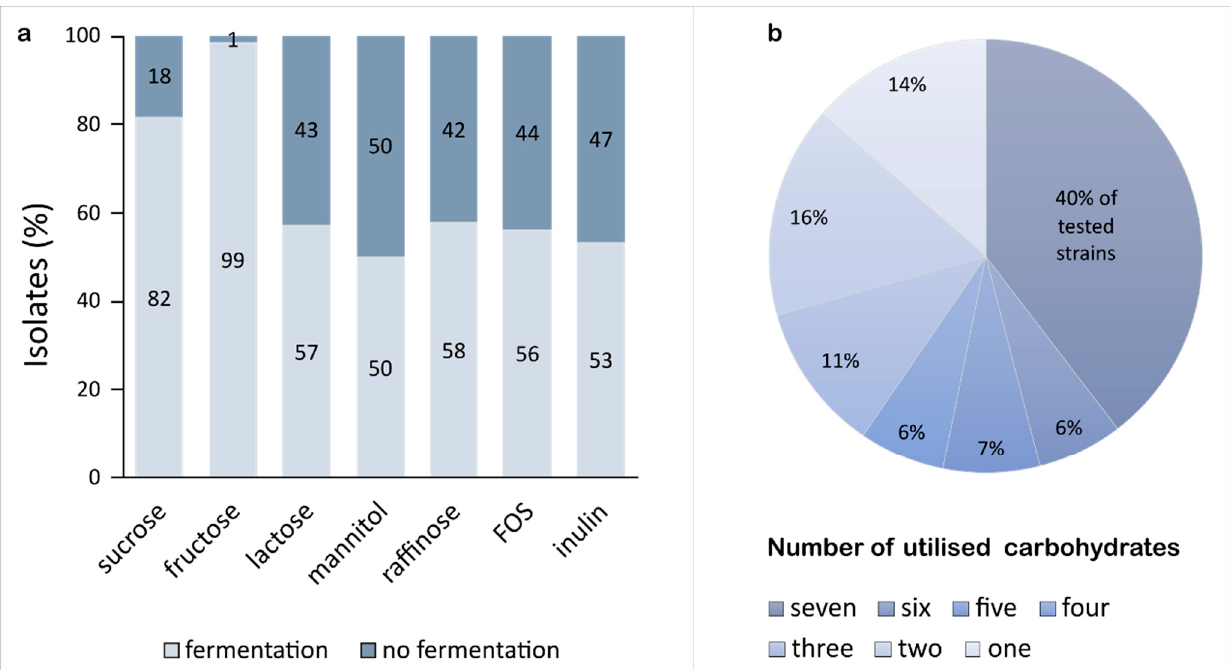
Figure 2. FODMAP fermentation analysis of 244 homofermentative LAB isolates as determined on mMRS agar containing a pH indicator (bromocresol purple), supplemented with either sucrose, fructose, lactose, mannitol, raffinose, FOS, or inulin (each at 0.5% ( w / v )); ( a ) LAB strains (%) established positive and negative for individual carbohydrate fermentation; and ( b ) strains (%) able to utilise a specific number of carbohydrates. Plates were inoculated at 30 ◦ C for 72 h in anaerobic conditions. Ability to ferment specific carbohydrate was indicated by a yellow discolouration zone surrounding a colony.